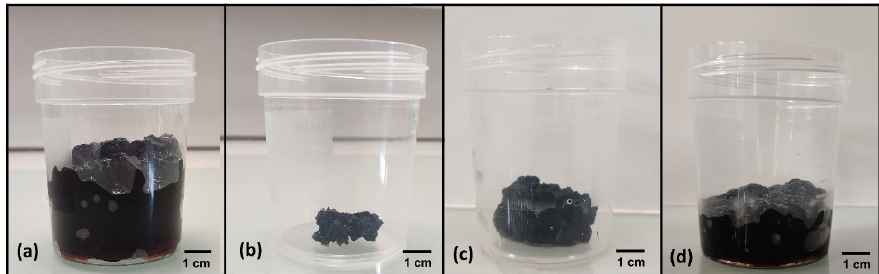
Figure 2. ( a ) xyl-TCPP-1 swollen in water directly after reaction; ( b ) xyl-TCPP-1 after lyophilization; ( c ) xyl-TCPP-1 after 48 h; and ( d ) after 15 days of swelling in water.